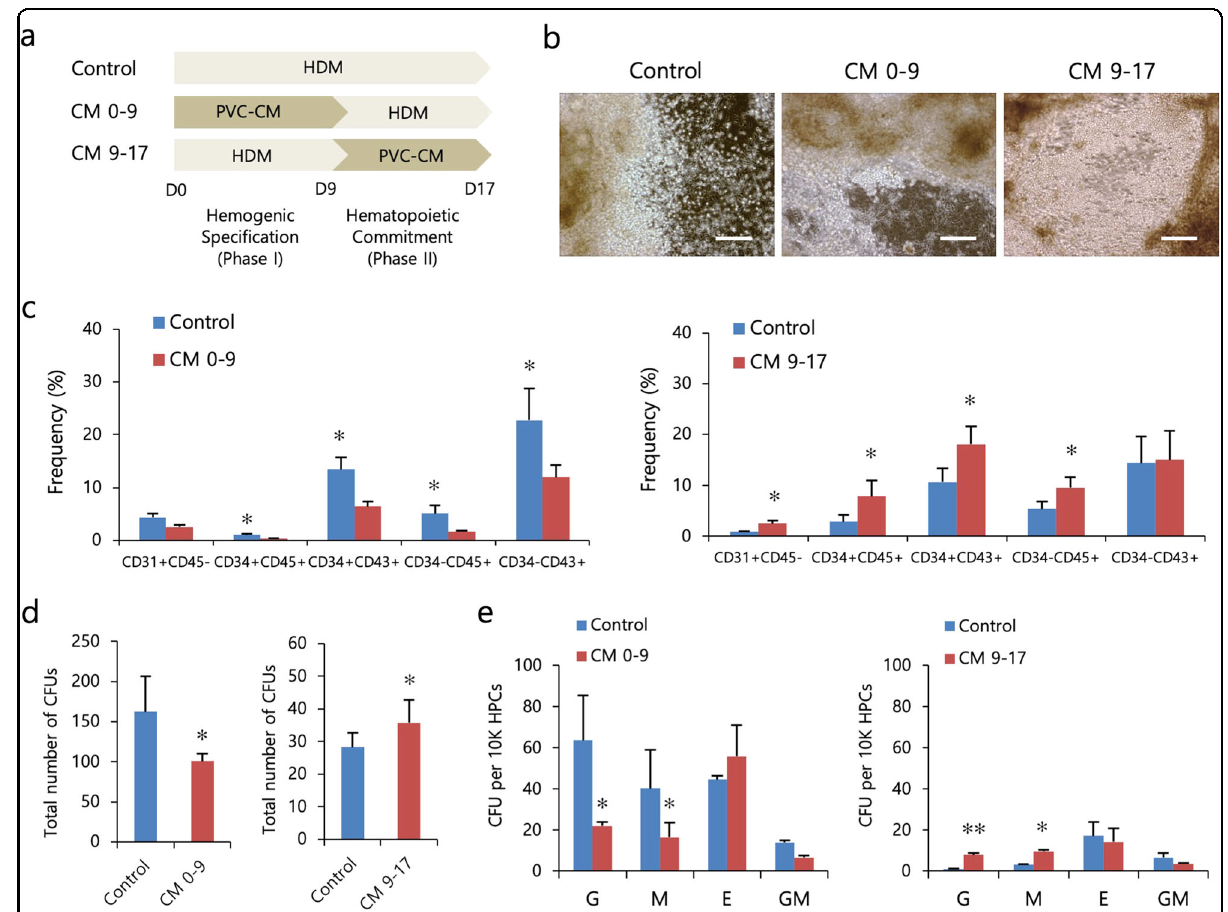
Fig. 4 PVCs enhance the hematopoietic differentiation of hPSCs via paracrine action. a Experimental scheme used to determine the paracrine effects of PVCs on the hematopoietic differentiation of hPSCs (CHA15 and iPS-NT4-S1). b Representative bright- fi eld images of colonies on day 17 of hematopoietic differentiation. Scale bar, 50 μ m. c Effects of PVC-CM on the production of hematopoietic lineage cells for two different exposure times (days 0 – 9 and days 9 – 17). d The total number of CFUs was counted by plating 1 × 10 4 cells in methylcellulose. e Distribution of CFU subtypes. The bars indicate the mean ± SD; * p < 0.05, ** p < 0.01 (control vs. CM 0 – 9 or CM 9 – 17). CFU-GM,